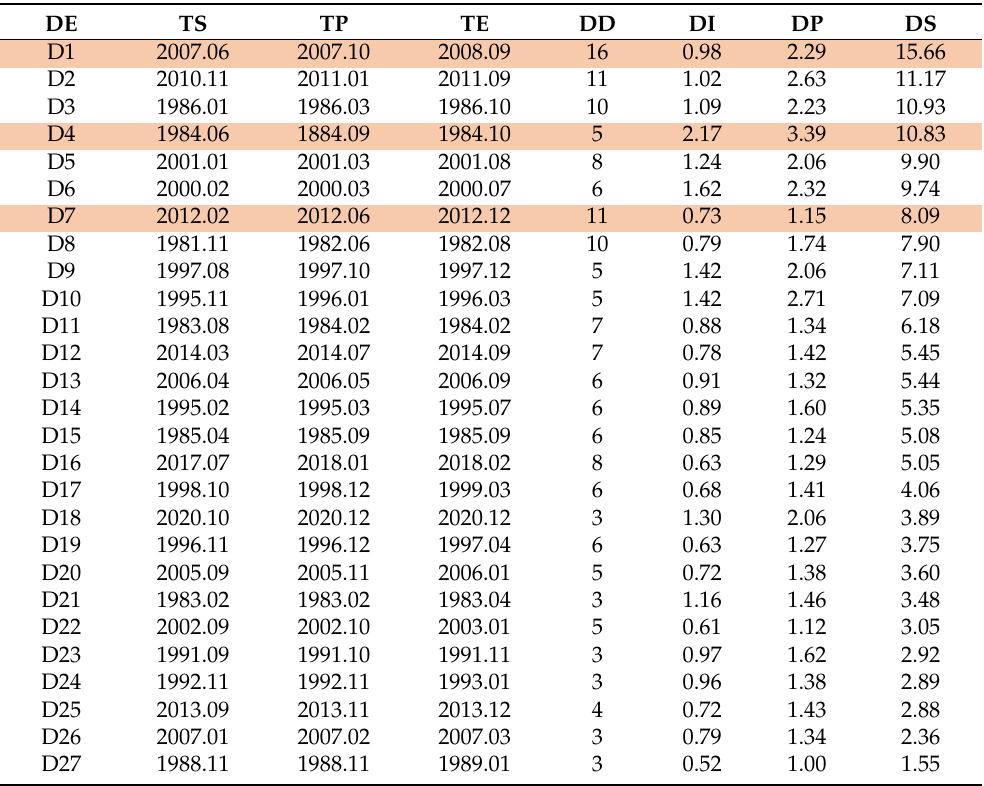
Table 3. Drought events and their characteristics in the study